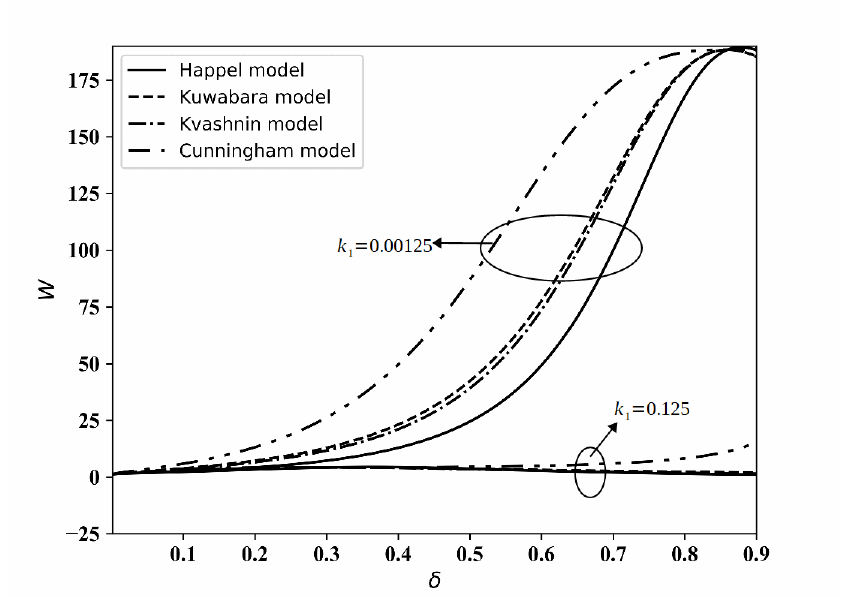
Figure 2. Variation of 𝑊 with 𝛿 for different values of 𝑘